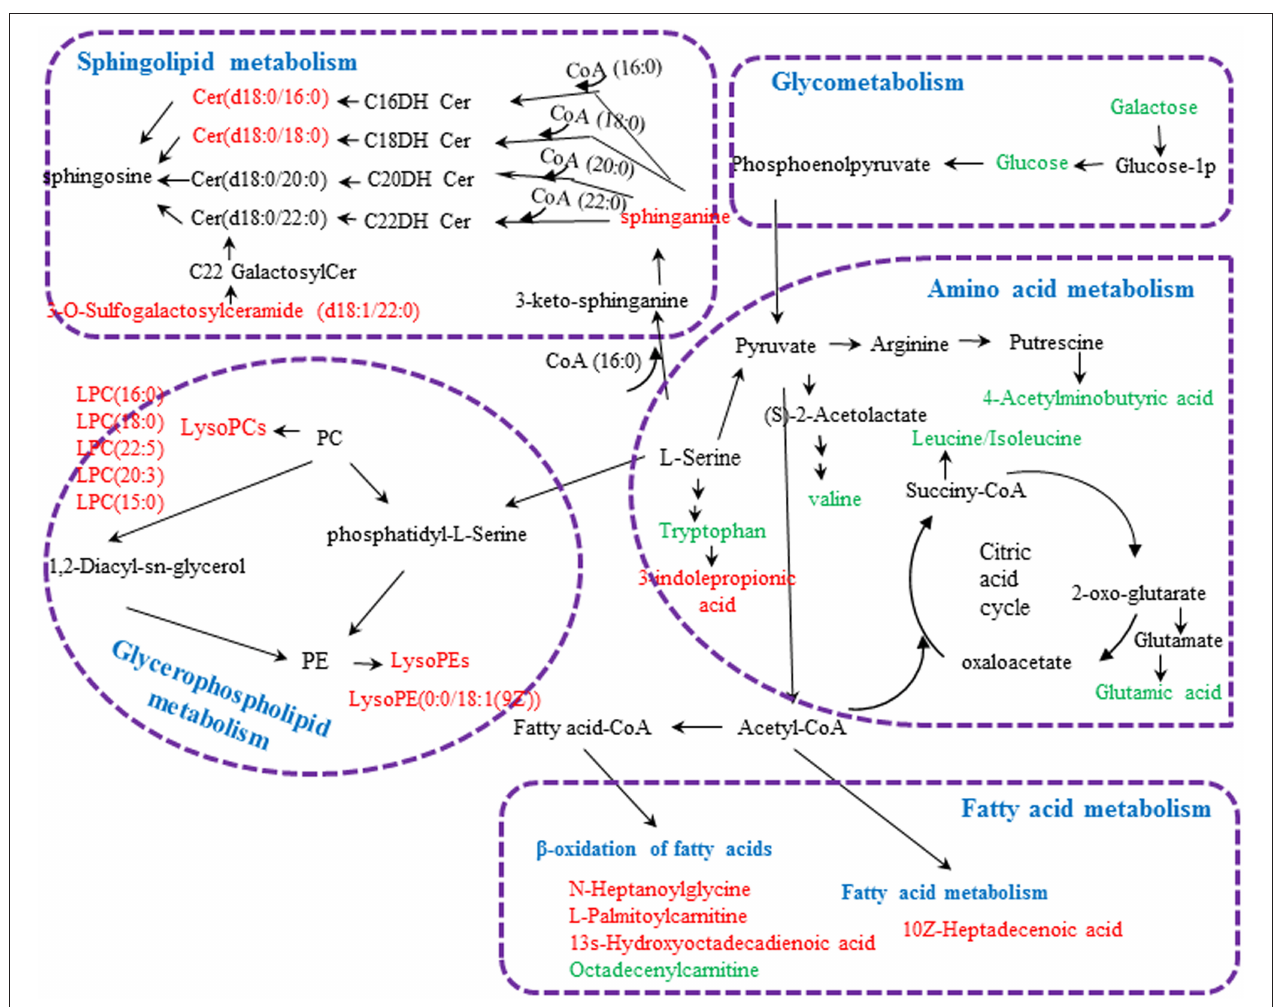
FIGURE 4 | Metabolic pathways involved in the [CM] group vs. the [K] group. Red fonts represent up-regulated metabolites in the [CM] group vs. the [K] group; Green fonts represent down-regulated metabolites in the [CM] group vs. the [K] group. Blue fonts represent the metabolic